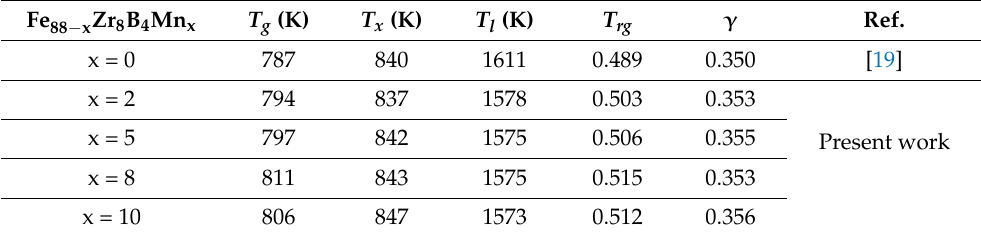
Figure 2. DSC traces of the Fe 88 − x Zr 8 B 4 Mn x (x = 2, 5, 8, 10) alloys with the heating curves obtained at 0.333 K/s. ( a ) shows the glass transition temperature ( T g ), crystallization temperature ( T x ) and ( b ) is the liquid temperature ( T l ). Table 1. Thermal properties of Fe 88-x Zr 8 B 4 Mn x amorphous samples.